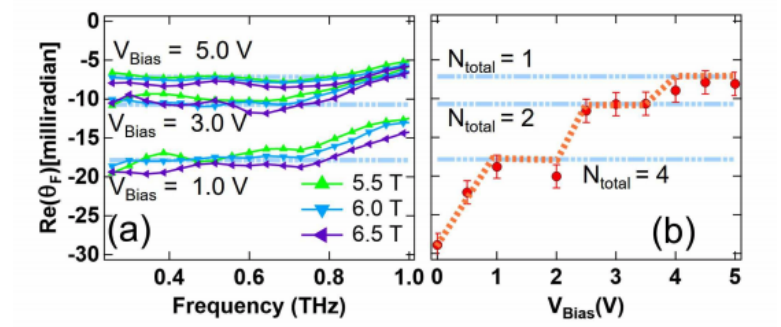
Figure 14: Left) (a) Real part of Faraday rotation ( θ sample with ionic liquid gated at difference voltages, B > 5.5T. The grey lines are theoretically predicted values assuming particular filling factors of the surface